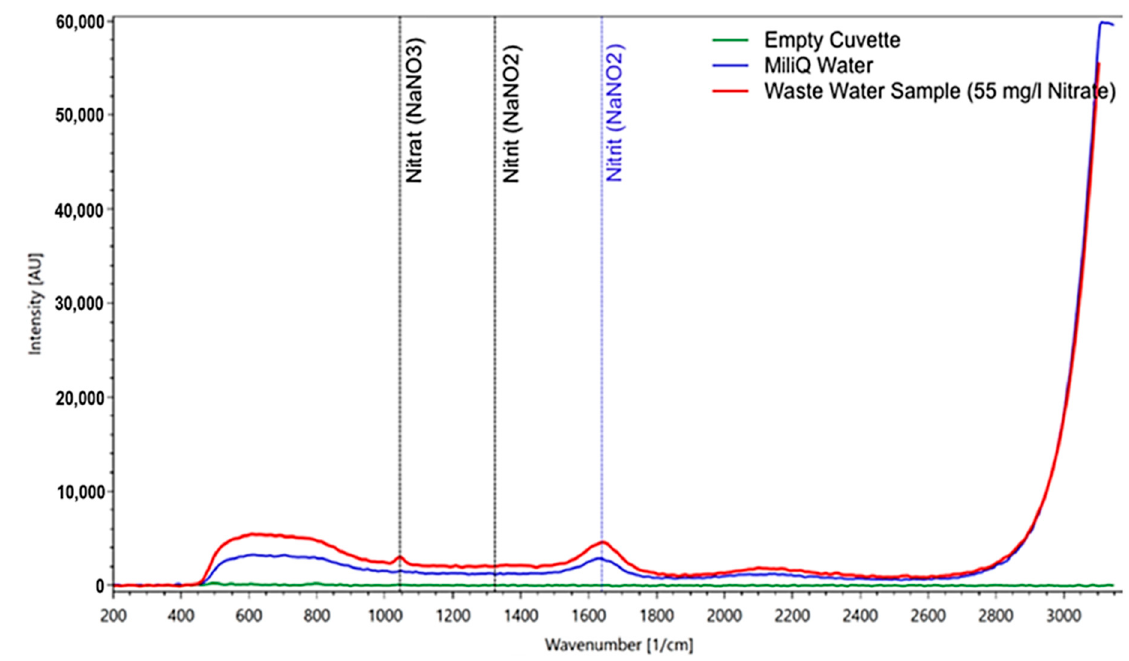
Figure 9. Measurement of a wastewater plant sample (after the biological cleaning stage) containing 55 mg/l of nitrate according to the independent lab analysis. For comparison, the spectrum of pure water and of the empty cuvette are included. The nitrate peak is clearly visible and not obscured by any other substances in the sample.